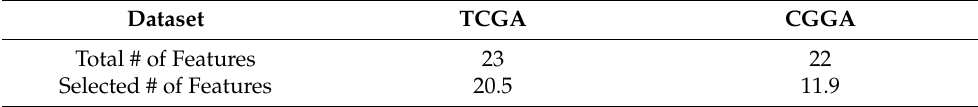
Table 11. The mean number of selected features after applying LASSO feature